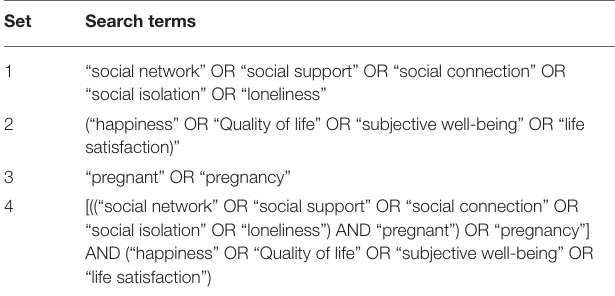
TABLE 1 | Search term for the literature